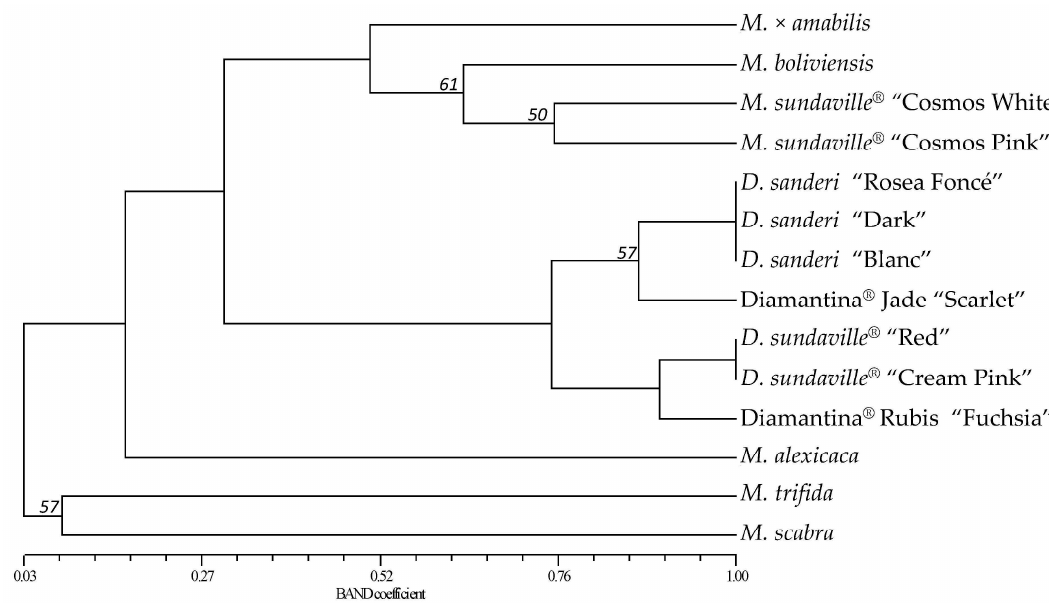
Figure 2 . Dendrogram of the 14 Mandevilla genotypes studied based on UPGMA analysis using the similarity matrix generated by the BAND coefficient after amplification with 20 pairs of SSR primers. Bootstrap values out of 2000 replicates are shown if 80% or lower.